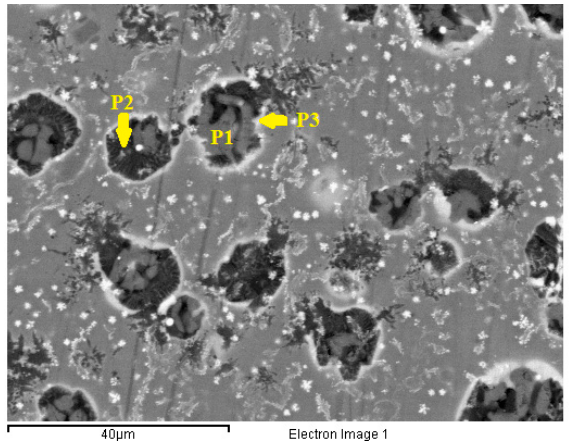
Figure 7. Details of crystals morphology after reaction lasted for 20 min.